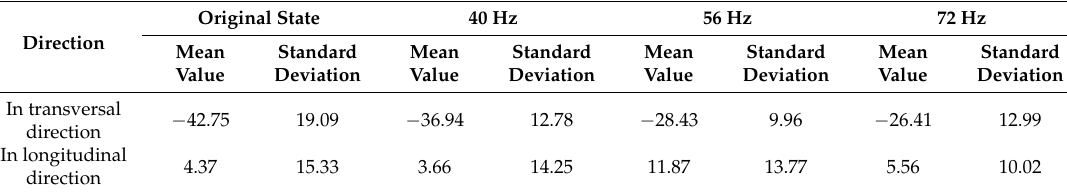
Table 4. Standard deviation and mean value of the average stress at four measuring points, before and after VSR at different temperatures. Unit: MPa.